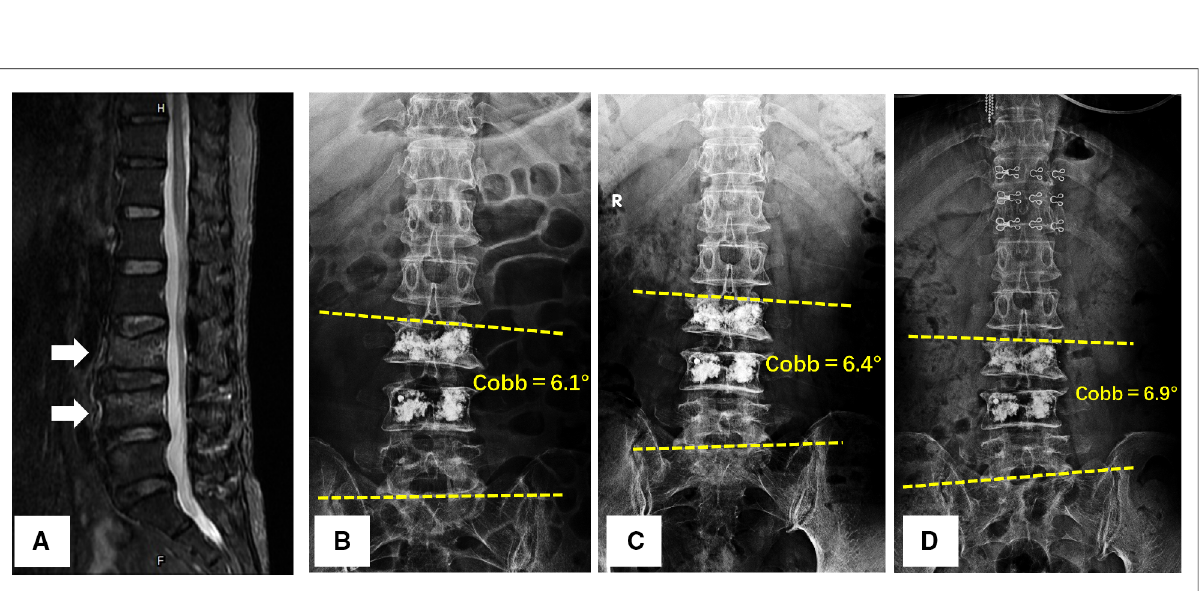
FIGURE 5 A 64-year-old female was diagnosed with L3 and L4 vertebral compressed fractures treated with bilateral PVP. ( A ) Preoperative T2-weighted MRI scan showed a higher-intensity signal within the fractured vertebral bodies; ( B – D ) 24 h after surgery, 6-month follow-up, and 48-month follow- up anteroposterior x -rays of lumbar spine, coronal segmental cobb angle varied little over